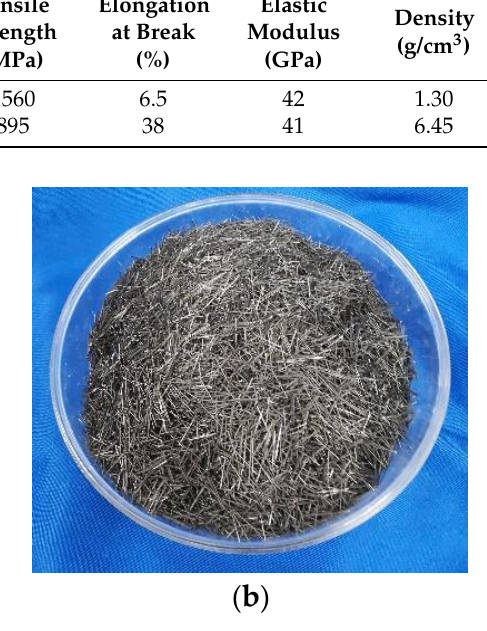
Figure 2. PVA fiber and SMA fiber pictures. ( a ) PVA fiber; ( b ) SMA fiber. Table 2. Mix proportion of MC.